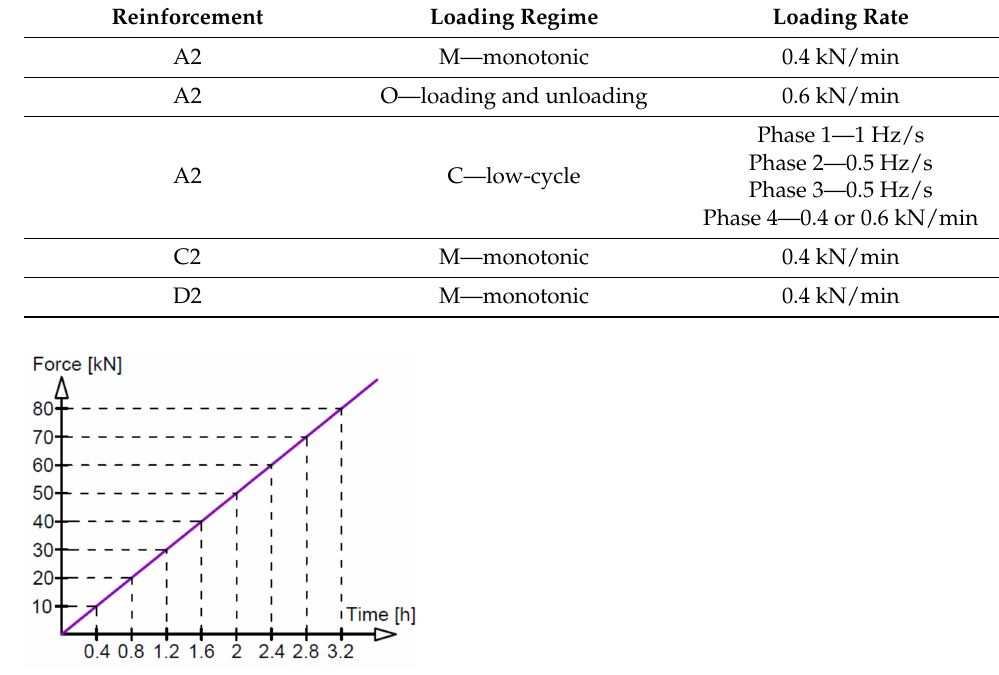
Figure 6. Monotonic loading.